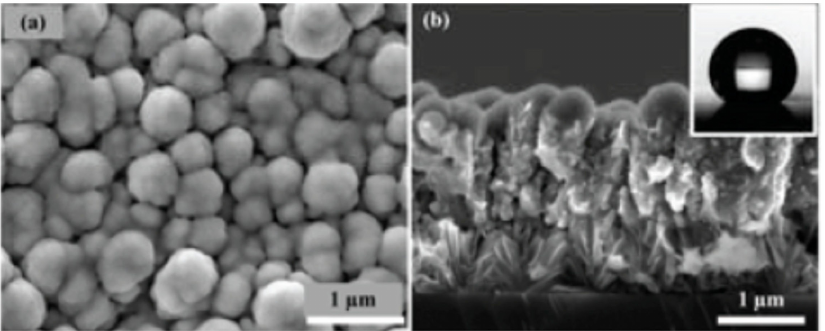
Figure7. SEMphotosofMnO 2 / Al / fluorocarboncomposite. ( a )Cross-sectional; ( b )top-view. Reproduced from [34], with permission from Initiators & Pyrotechnics,